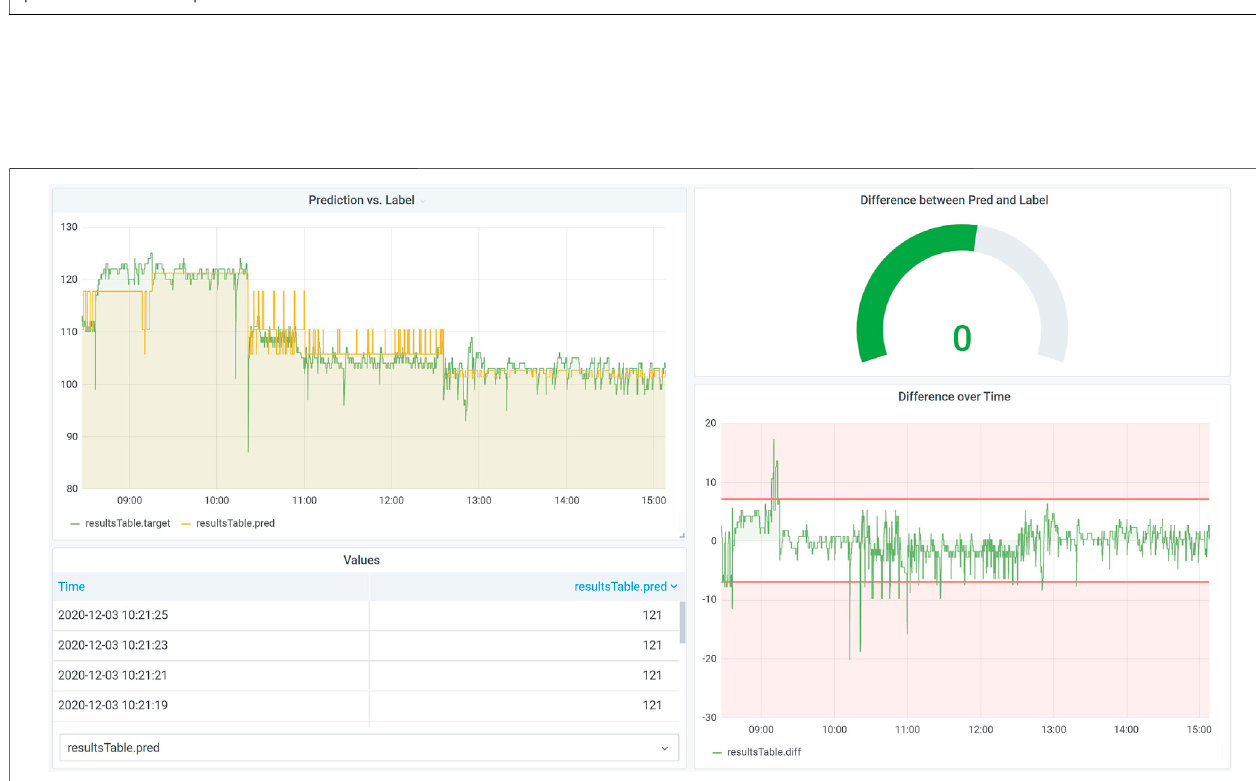
FIGURE 5 | Visualization of model predictions in Grafana including line plot, textual representation in table and gauge with thresholds. The predicted value of the mock-up scenario represents the temperature prediction within a machine hall. The gauge indicates whether the temperature is within a suitable range using the mean predicted value of the past 10 min.